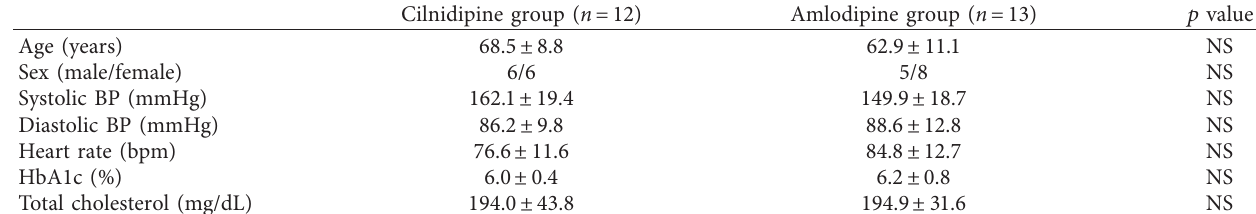
Table 1: Characteristics of the study patients.